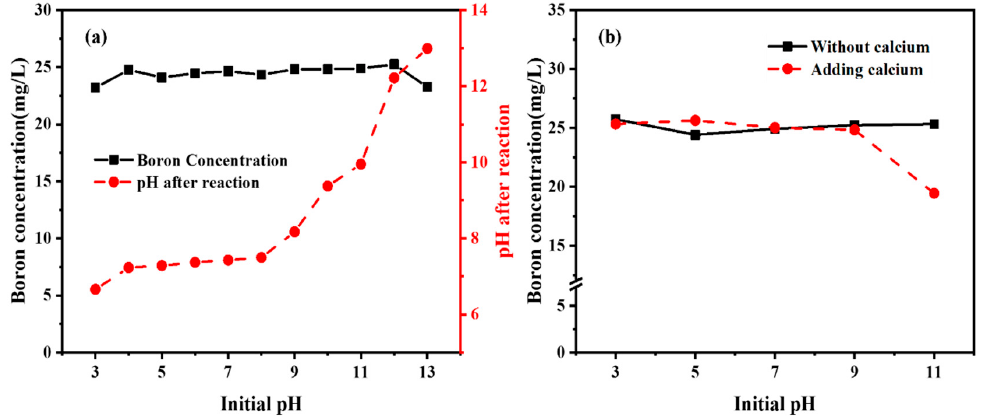
Figure 4. Removal performance and pH ( a ) pure hydroxyapatite (HAP); ( b ) HAP and extra calcium.